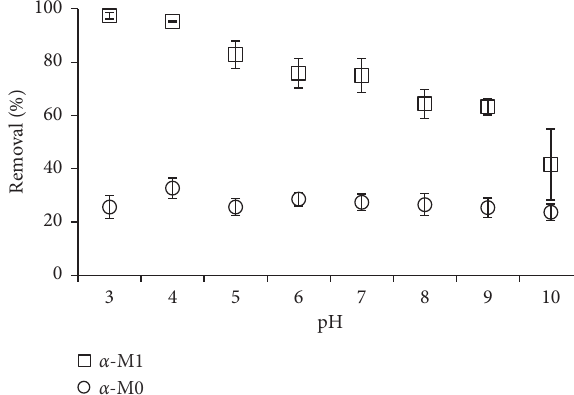
Figure 2: The effect of pH on RhB removal using α - M 0 and α - M 1 materials at 1mM NaCl (C i (RhB) � 10 − 5 M, adsorbent dosage of 5 mg/mL, and contact time of